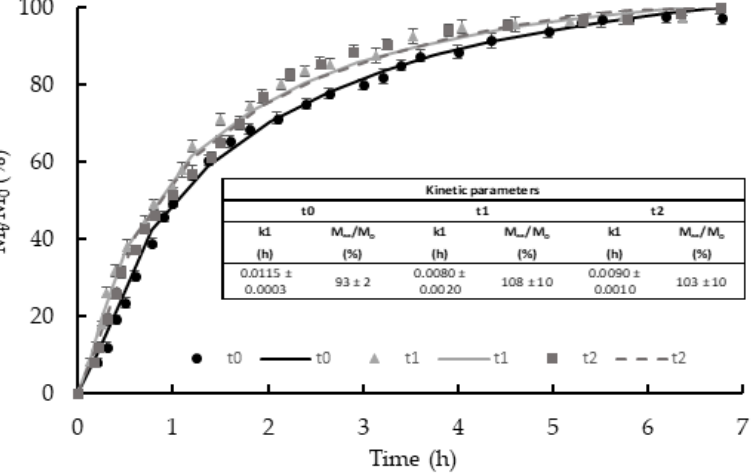
Figure 3. Values of M t /M o (ratio of the mass of FA released at each time with respect to the initial mass in the film) as a function of time (experimental points and fitted Pelegs’ model (lines)) for FA coated films stored for 0, 1 and 2 months. The embedded table shows the values of k1 Peleg’s parameter and the experimental values of M ∞ /M o (% released at equilibrium). Mean values and standard deviation.